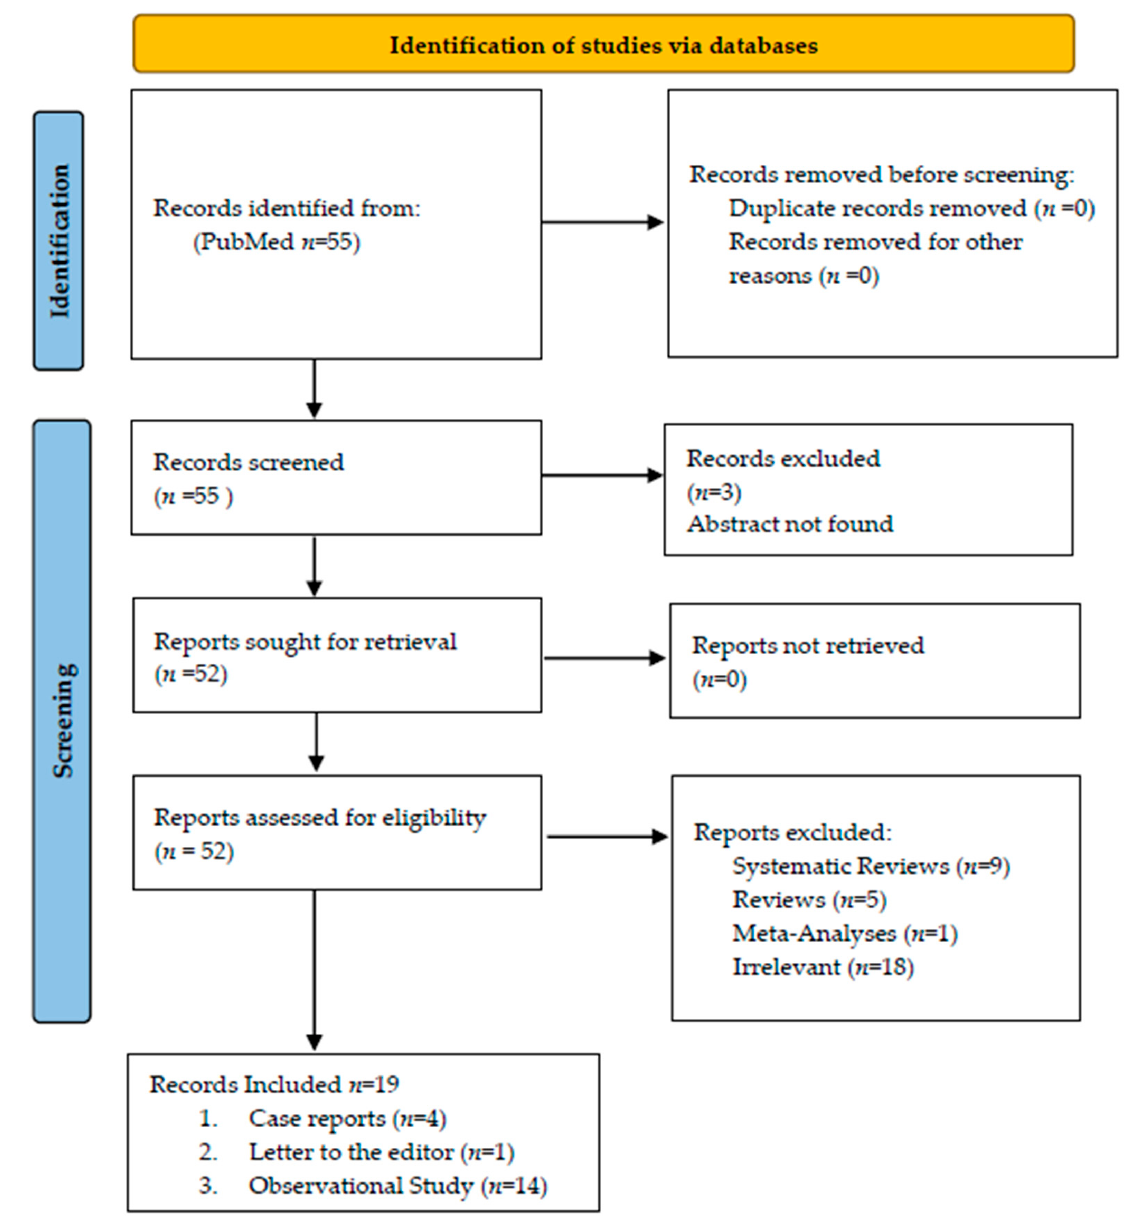
Figure 2. PRISMA flow chart.